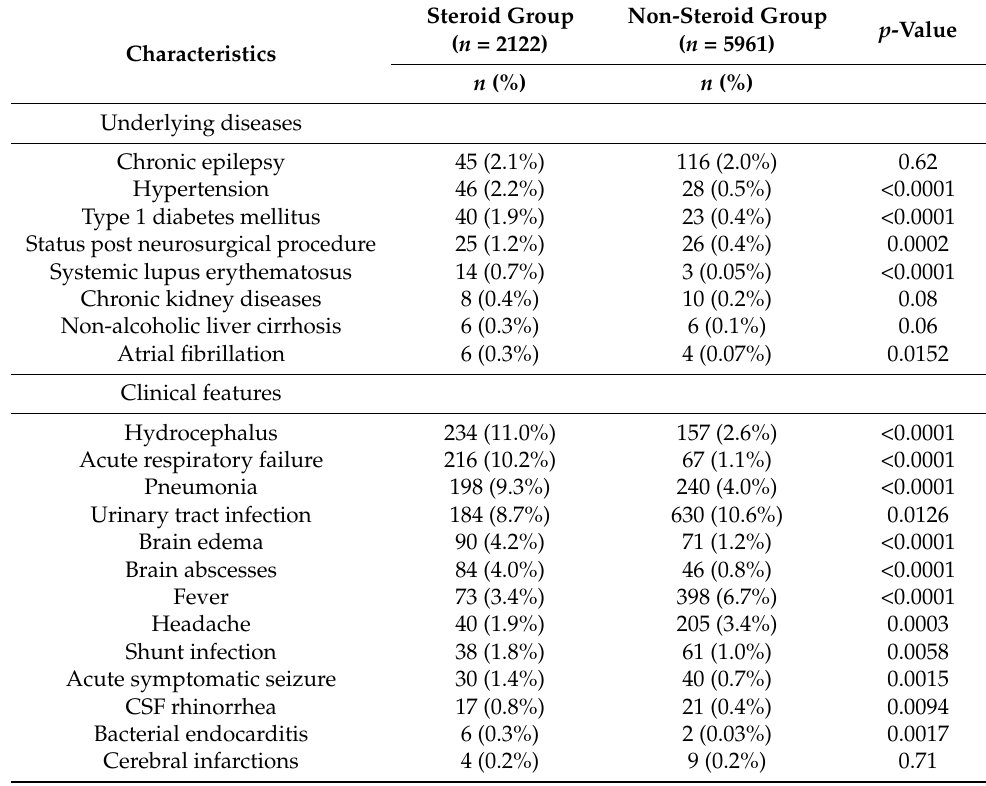
Table 3. Underlying diseases and clinical features.